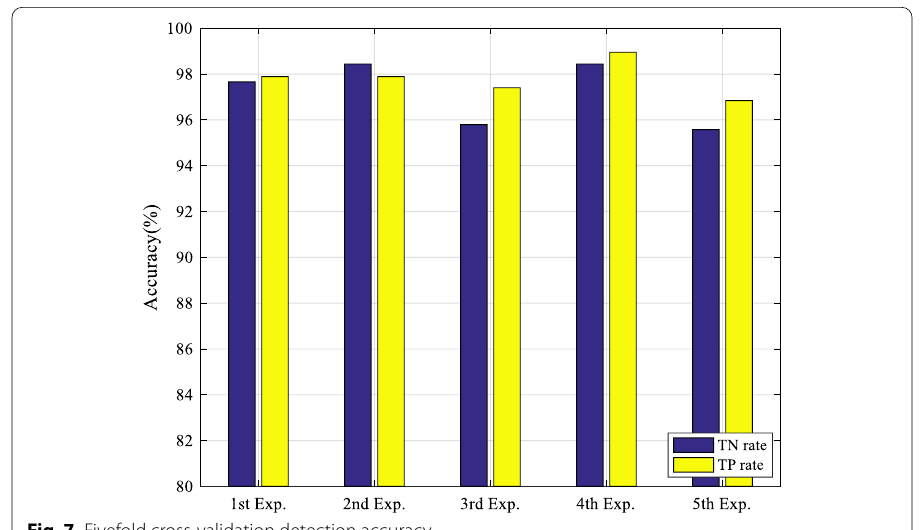
Fig. 7 Fivefold cross-validation detection accuracy